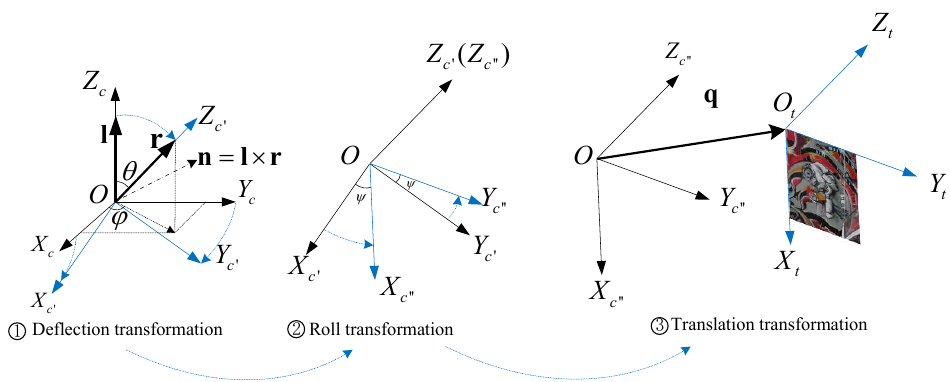
Figure A2. Three step transformation from the camera coordinate system to test image coordinate